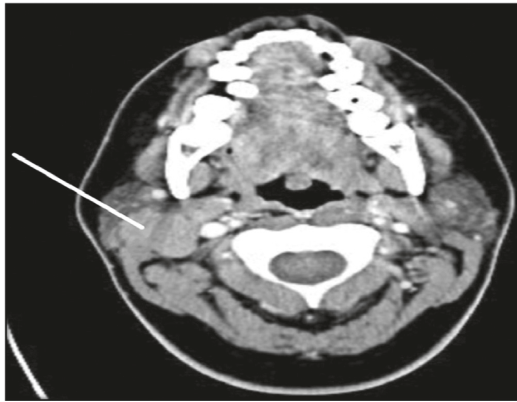
Figure 1: The CT scan showing a right parotid gland lesion in 2017.